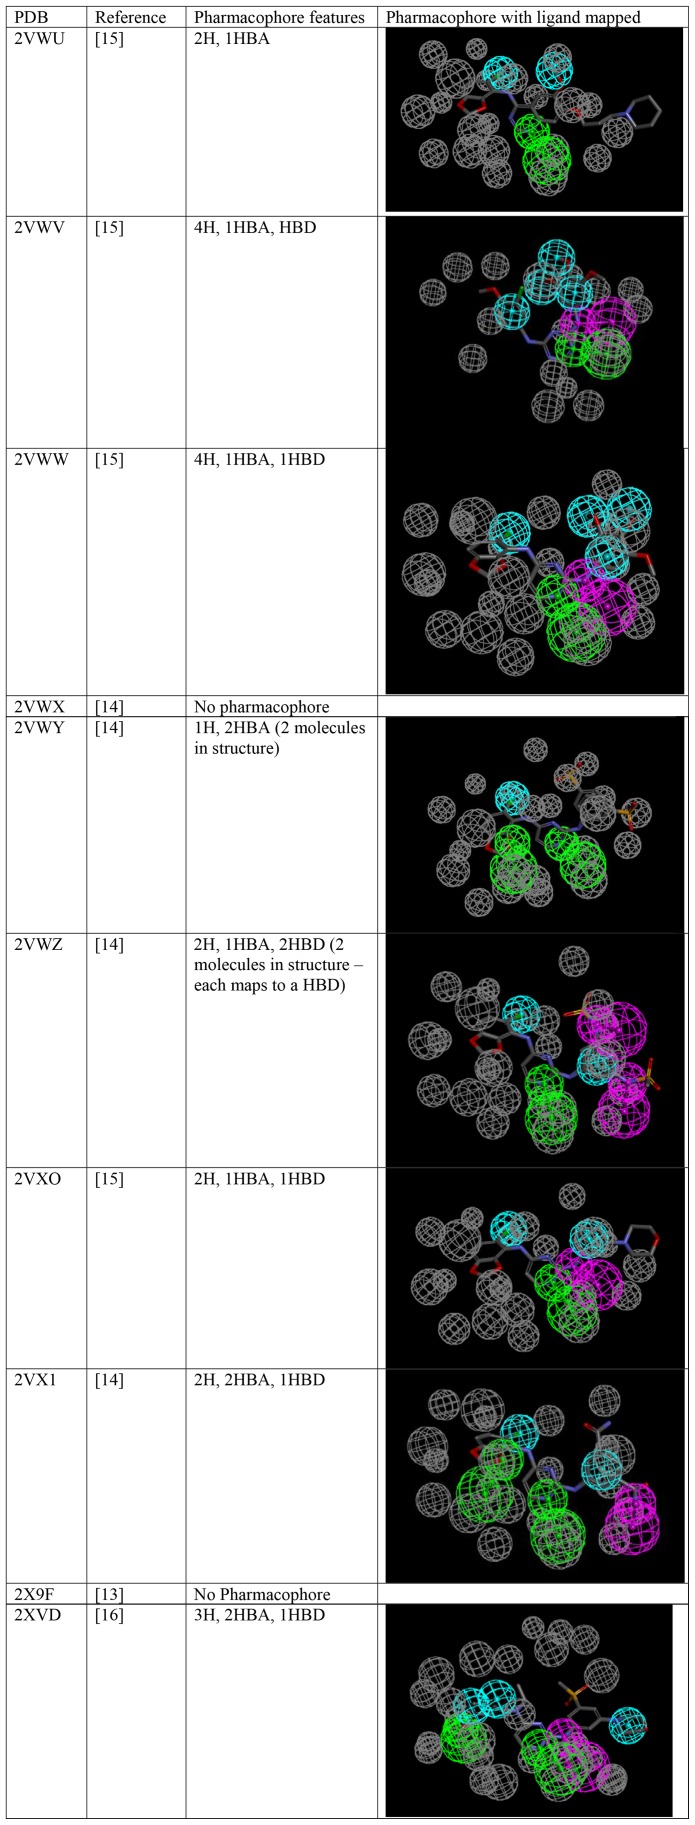
Pharmacophores for the tyrosine kinase EphB4 generated from crystal structures in the protein data bank (PDB).Pharmacophore features are Hydrophobic (H, cyan), Hydrogen bond acceptor (HBA, green) and hydrogen bond donor (HBD, purple). Excluded volumes (grey) were also automatically added.